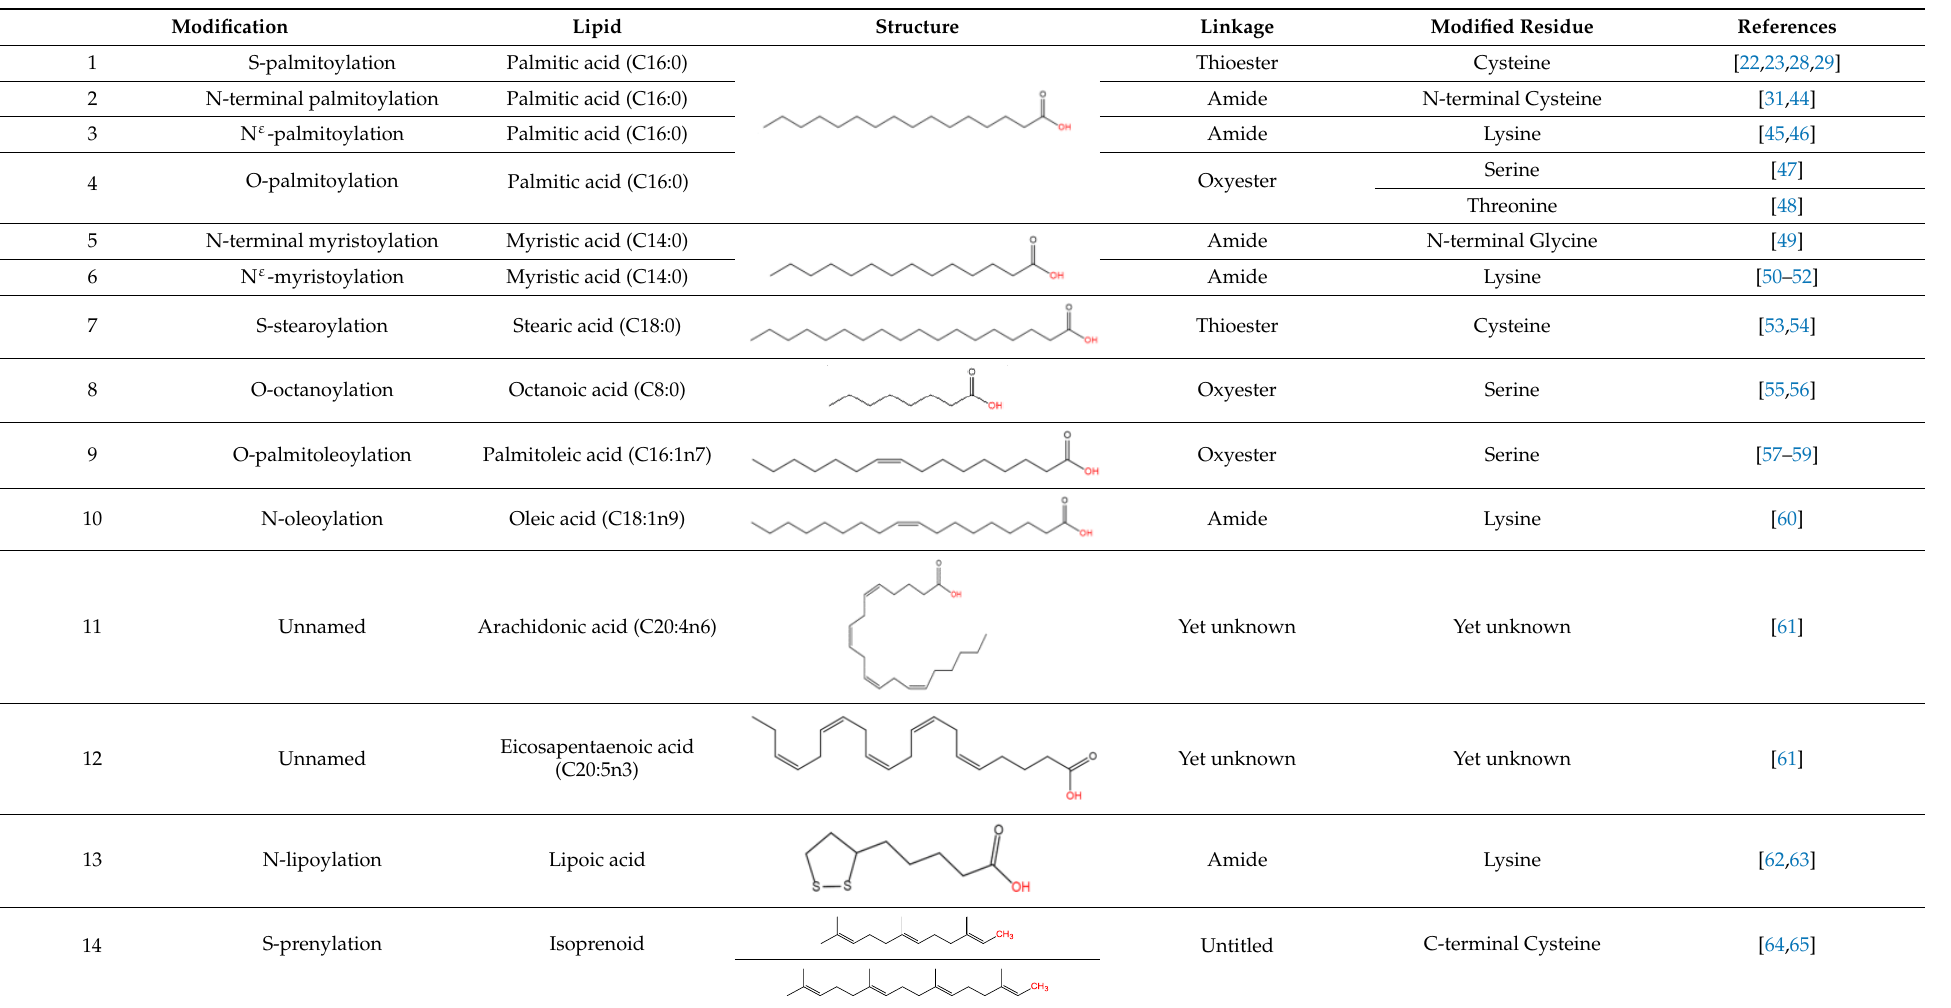
Table 1. Types of cellular protein lipidation.